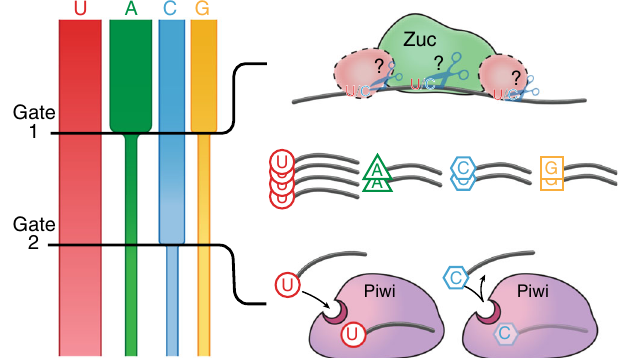
Fig. 5 Model for the establishment of a 1U-bias. Our data support that the 1U-bias is established in two steps by differential gating against all nucleotides but Uridine. First, purines (A/G) are reduced during piRNA biogenesis in an SL-independent manner. Consecutively, 1C is discriminated against upon piRISC formation by interactions with Piwi ’ s SL. (See also Supplementary Fig.